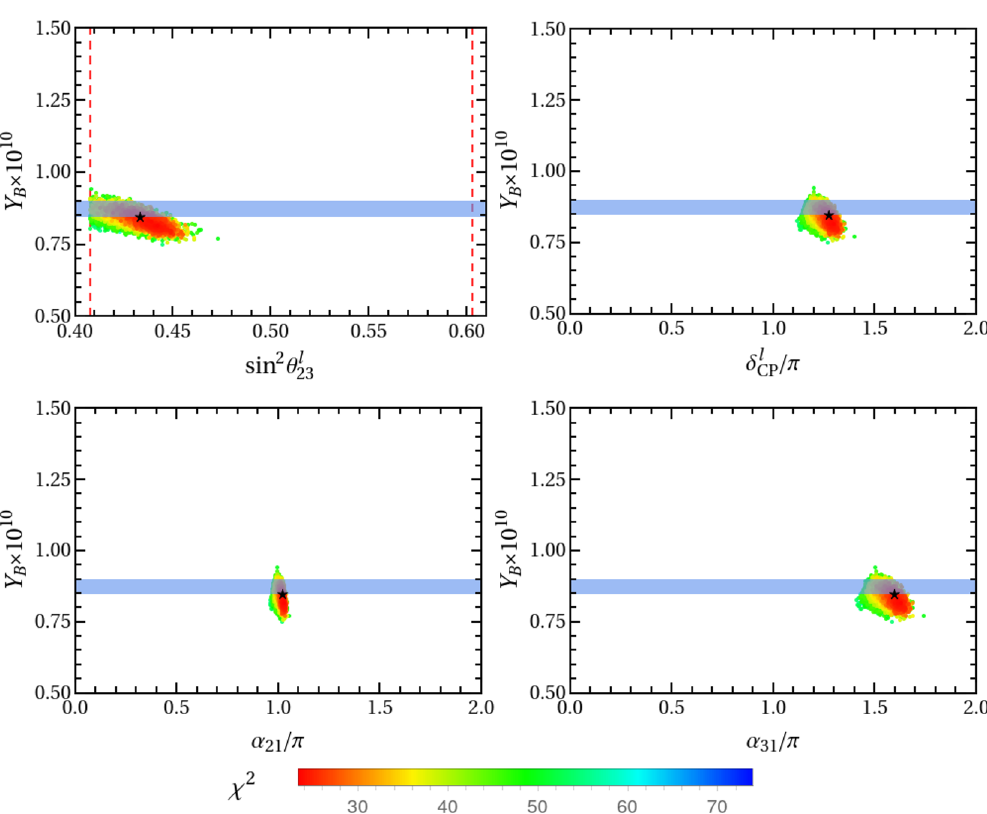
Figure 9 . The numerical results for the correlation between the baryon asymmetry Y B and sin 2 θ l δ l , α 21 , α 31 in the BM2 model with thermal initial condition. The horizontal band denotes the CP experimentally allowed region of Y B . The star “ F ” stands for the best fitting point in table 4. Note that the contribution of Y B to χ 2 is not included